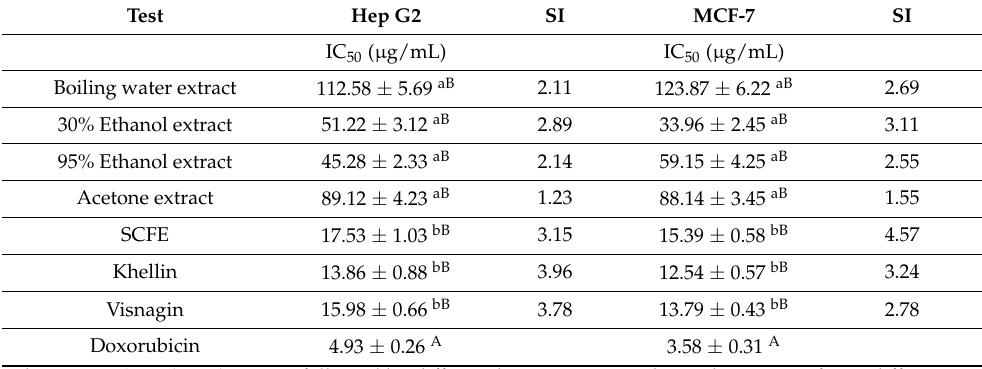
Table 2. In-vitro cytotoxic activity of A. visnaga extracts, standard khellin, visnagin and doxorubicin. Test Hep G2 SI MCF-7 IC 50 ( µ g/mL) IC 50 ( µ g/mL) Boiling water